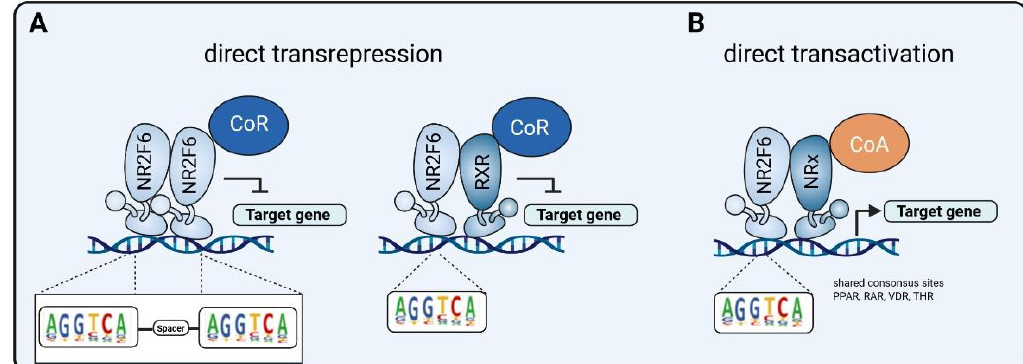
Figure 3. NR2F6 dimerization and mechanism of action. NR2F6 forms homo- and heterodimers (e.g., with RXRs) and acts, in a promoter context-dependent manner, either as a transcriptional repressor or an activator. Although natural ligands for NR2F6 are currently unknown, in the future, the potential druggability of its LBD for a “small-molecule checkpoint blockade drug” could provide a rational mechanistic basis for the targeted manipulation of NR2F6 in T cells. ( A ) By directly binding to GGTCA tandem motifs, i.e., as direct repeats separated by an appropriate spacer, and by forming complexes with a co-repressor (CoR), NR2F6 modulates target gene transrepression. Mechanistically, NR2F6 interferes with the transactivation of the target gene by other transcription factors and/or nuclear hormone receptors either through the sequestration of, e.g., RXR away from other DNA-bound protein–protein interaction complexes or through a direct occupation of their critical DNA-binding sites. ( B ) By direct binding as a heterodimer to a single GGTCA motif in close proximity to other DNA-bound nuclear receptors and by forming complexes with a co-activator (CoA), NR2F6 mediates transactivation of target gene expression. Adapted from Tang et al. [68].